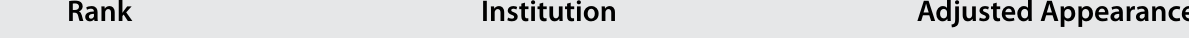
Table 9. Top Institutions Ranked by Adjusted Appearances